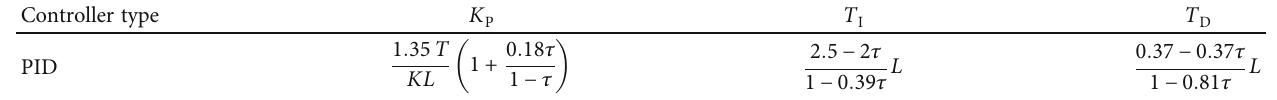
Table 4: Controller parameters for the Cohen-Coon